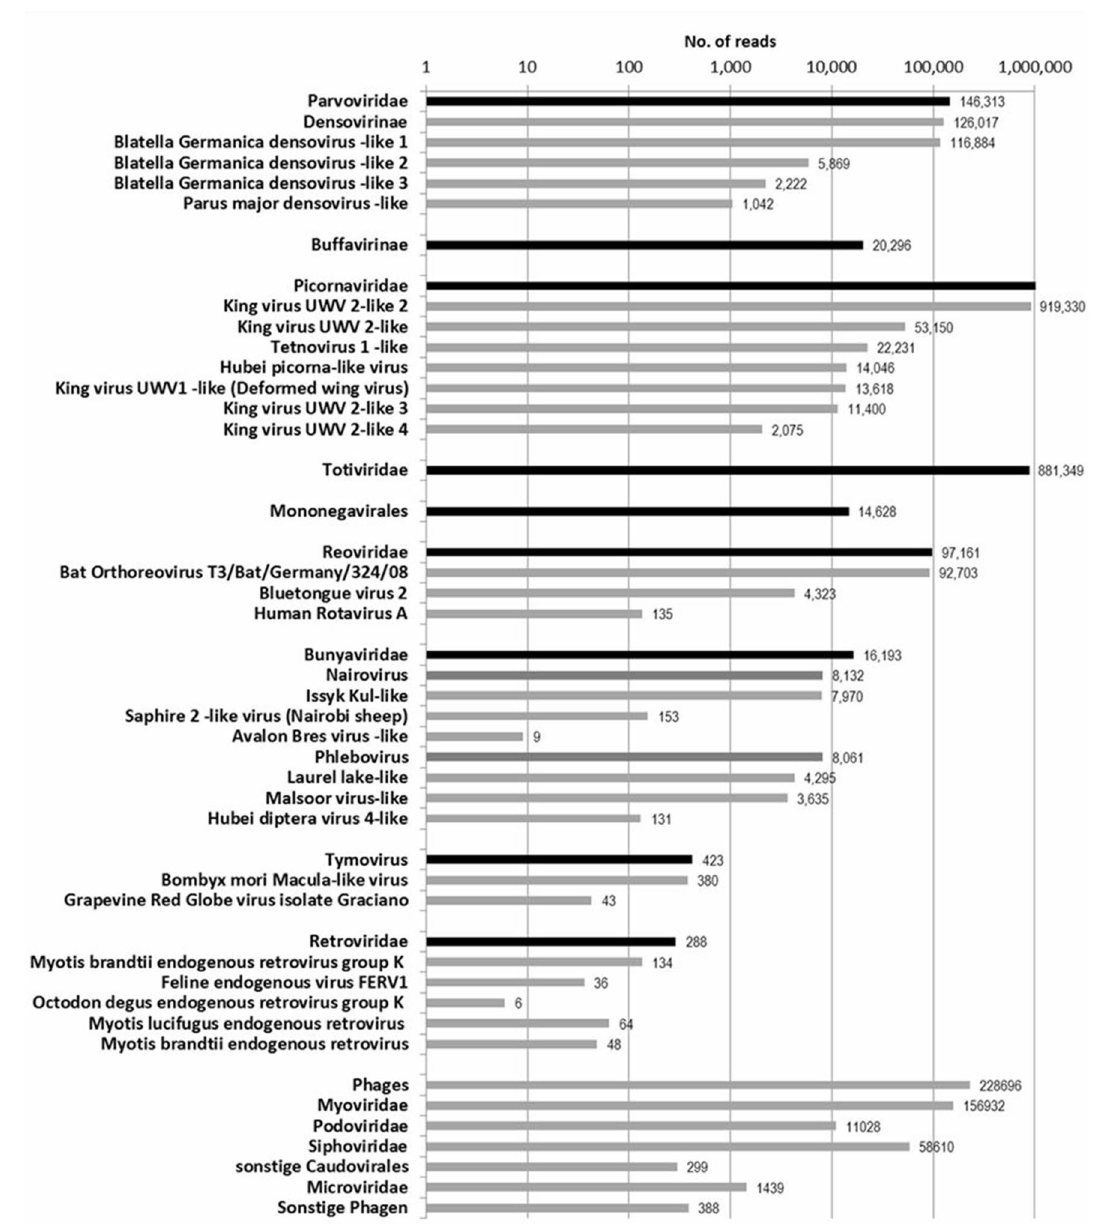
Figure 2. Schematic summary of the number of reads related to viruses classified by viral genus, subfamily and family. Viruses that did not meet the quality criteria were